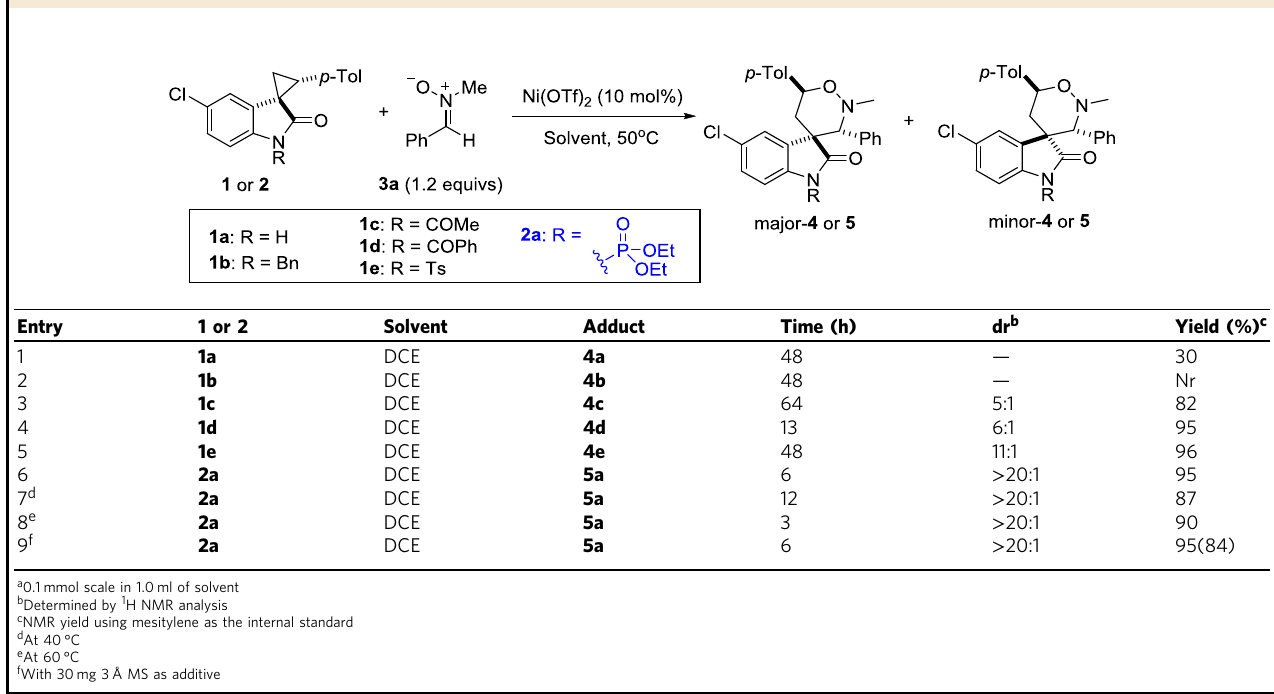
Table 1 Evaluation of N -withdrawing protection group a